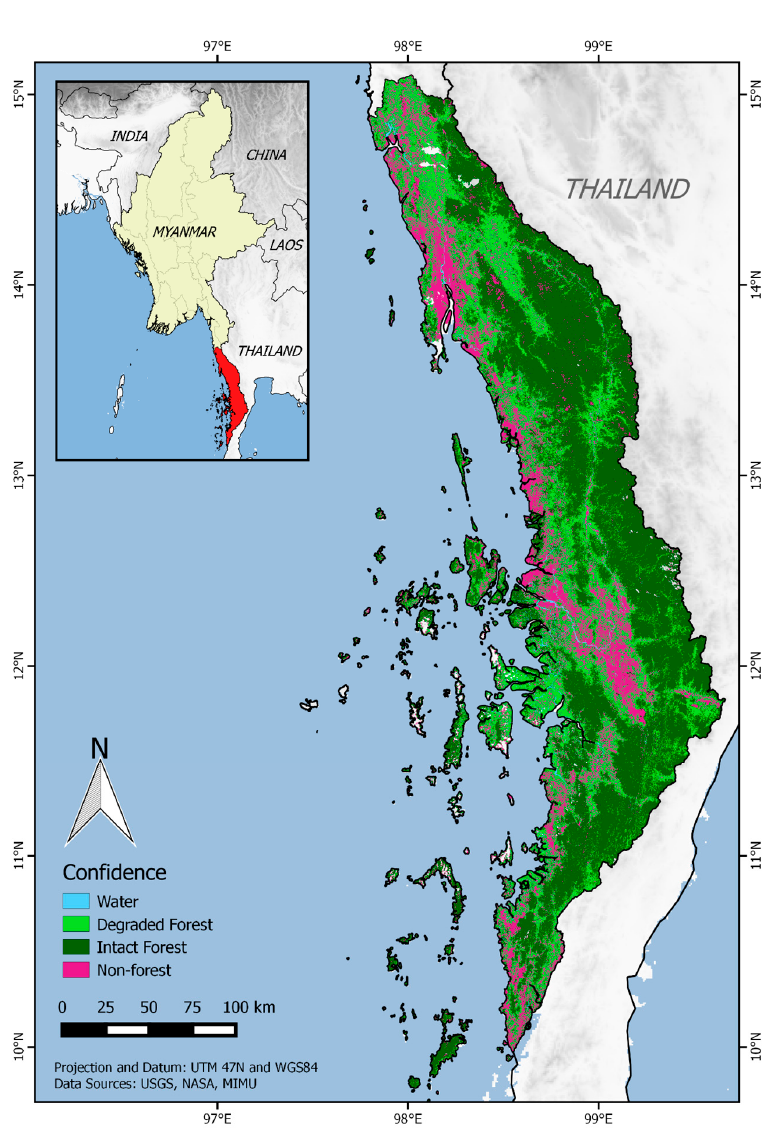
Figure 3. Combined extents of intact forest, degraded forest, and non-forest classes for Myanmar’s Tanintharyi Region. Table 2. Terrestrial land cover by area in Tanintharyi, Myanmar.